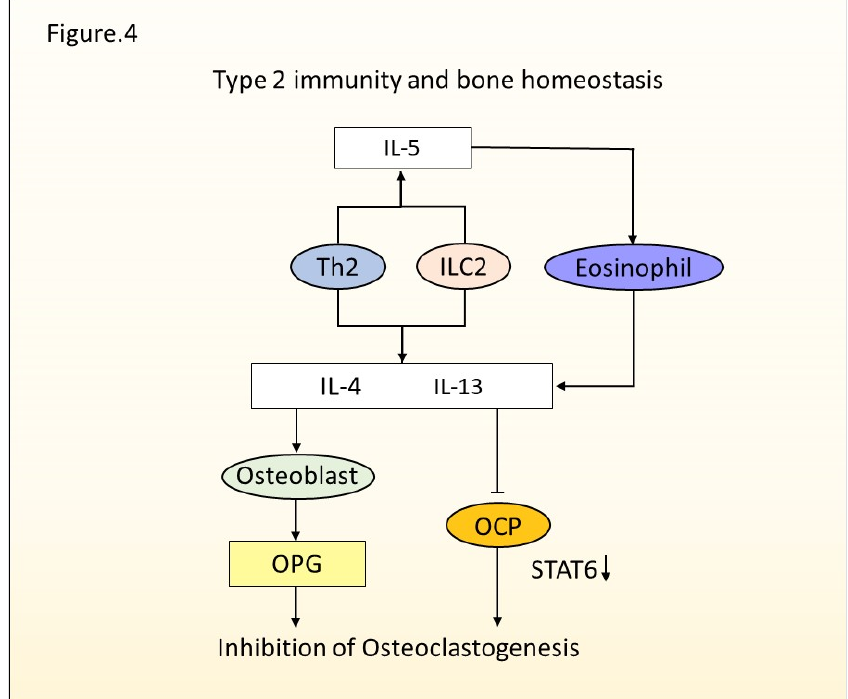
Figure 4. Type 2 immunity and bone homeostasis. Th2 cells and ILC2s generate IL-4, IL-5, and IL-13. IL-5 activates eosinophil, and it secretes IL-4 and IL-13. Type 2 cytokines suppress the differentiation of osteoclasts by regulating the expression of STAT6. Type 2 cytokines stimulate osteoblasts to generate OPG, which inhibits osteoclastogenesis.